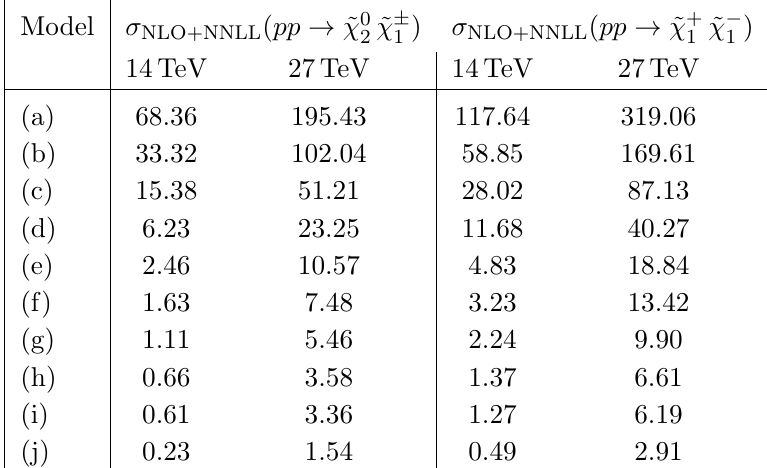
The NLO+NNLL production cross-sections, in fb, of electroweakinos: the second neutralino-chargino pair, ~ (cid:31) 0 ~ (cid:31) (cid:6) (second and third columns), and opposite sign chargino pair (fourth 2 1 p p and (cid:12)fth columns) at s = 14 TeV and at s = 27 TeV for benchmarks of table 1.